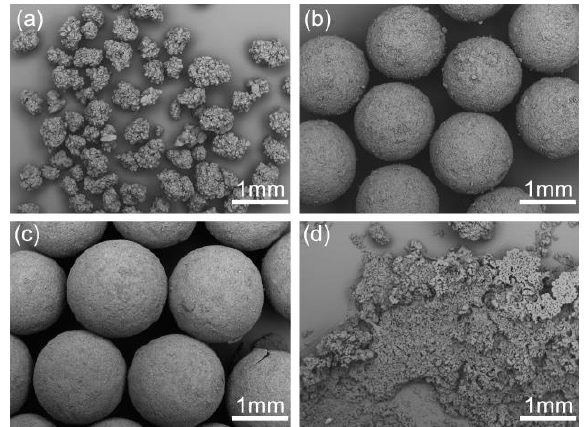
Figure 9. SEM images of the spherical crystals prepared at different dosages of bridging liquid ( a ) 6 mL, SA-5; ( b ) 8 mL, SA-6; ( c ) 12 mL, SA-7; ( d ) 15 mL, SA-8.